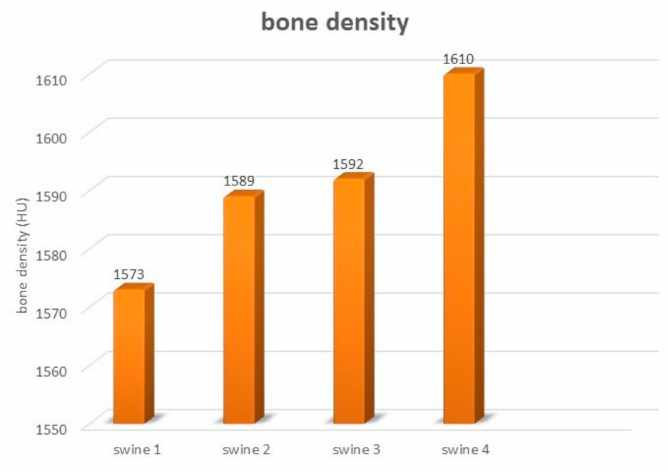
Figure 11. The bone density of the mandible in evaluated experimental animals.